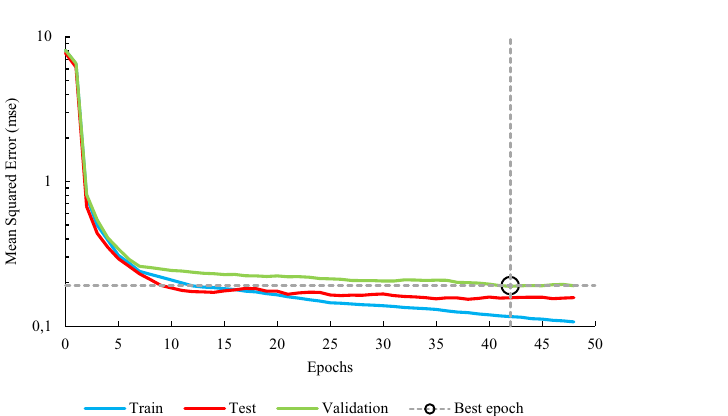
Figure 3. Dynamic performance of the ANN with architecture